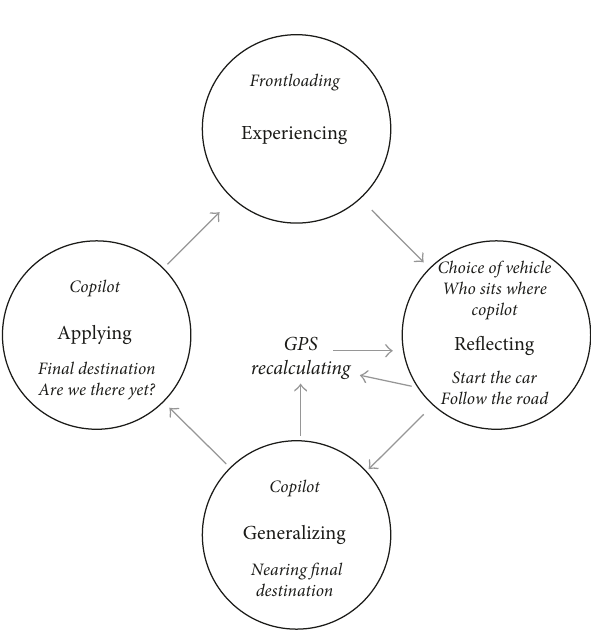
Figure 1: Sunday Afternoon Drive Debrief Model (Sutherland et